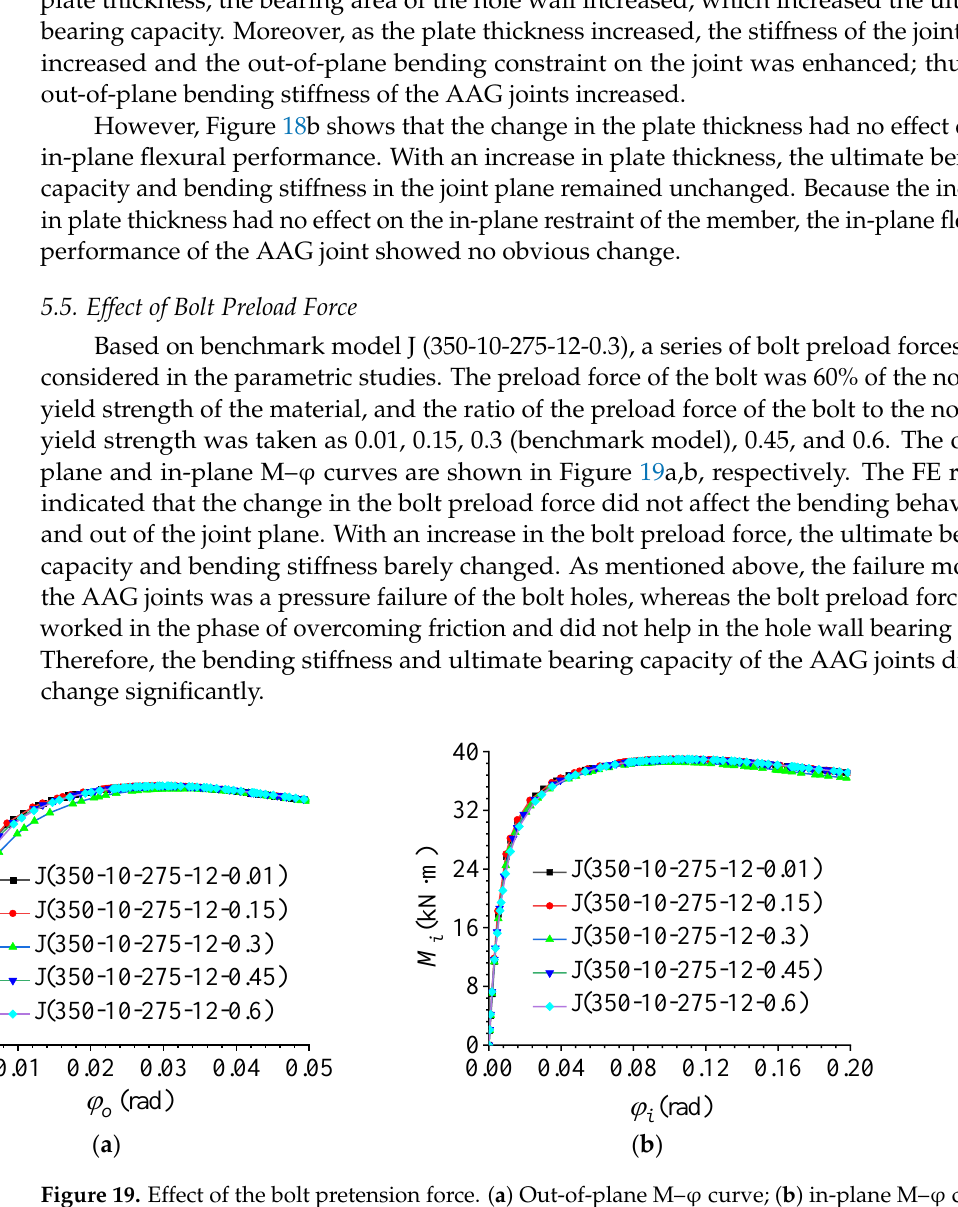
Figure 18. Effect of joint plate thickness. ( a ) Out-of-plane M–φ curve; ( b ) in-plane M–φ curve.